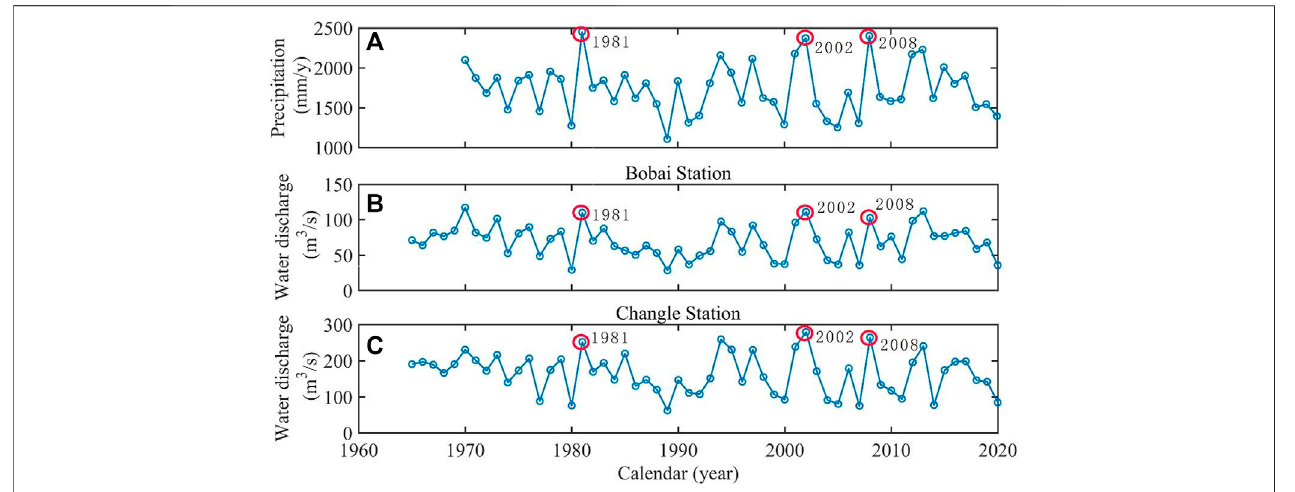
FIGURE 9 | Change trend of the precipitation and water discharge from 1965 to 2020 (A) yearly average precipitation; (B) yearly average water discharge at the Bobai station; (C) yearly average water discharge at the Changle station.